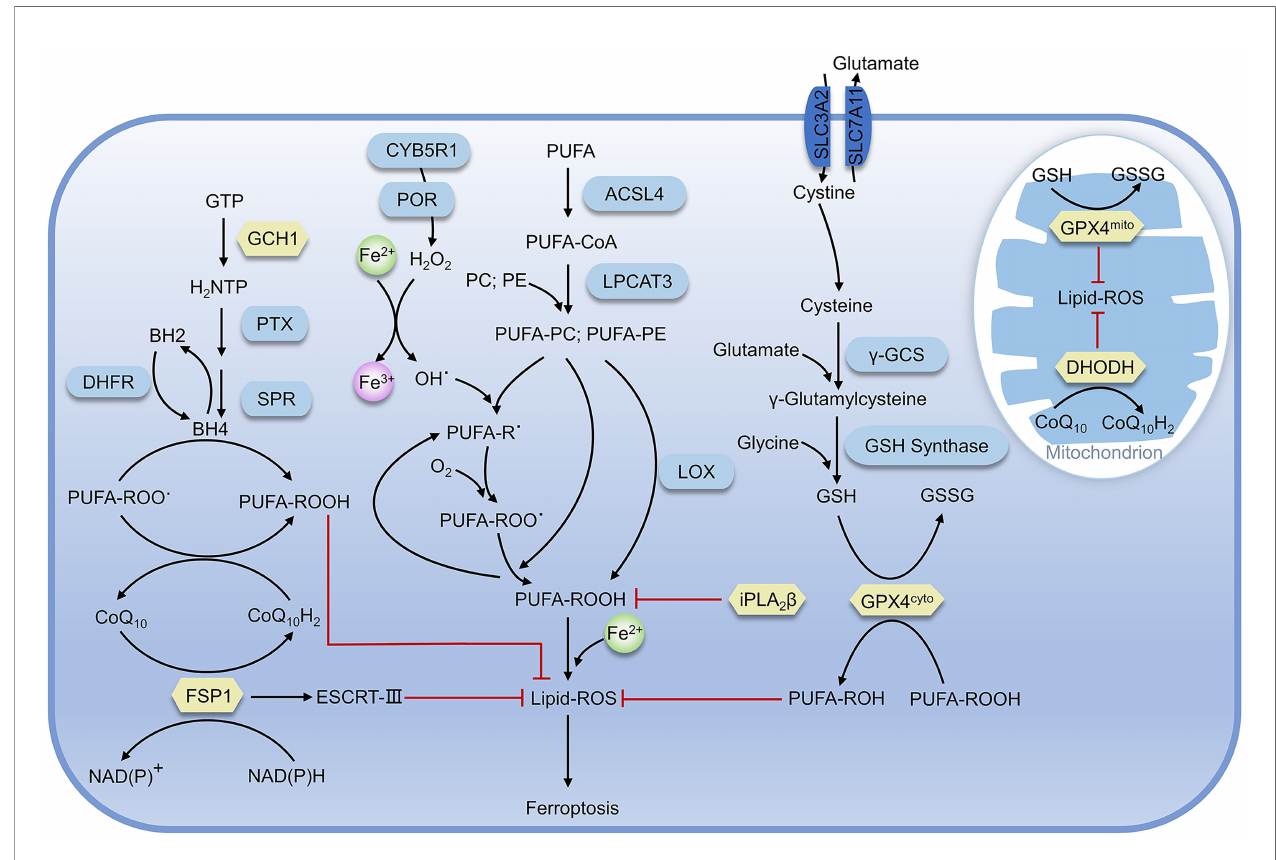
FIGURE 2 | Regulatory pathways of ferroptosis. The proteins in yellow are key defense systems; the red line represents inhibiting effect (as in Figure 4